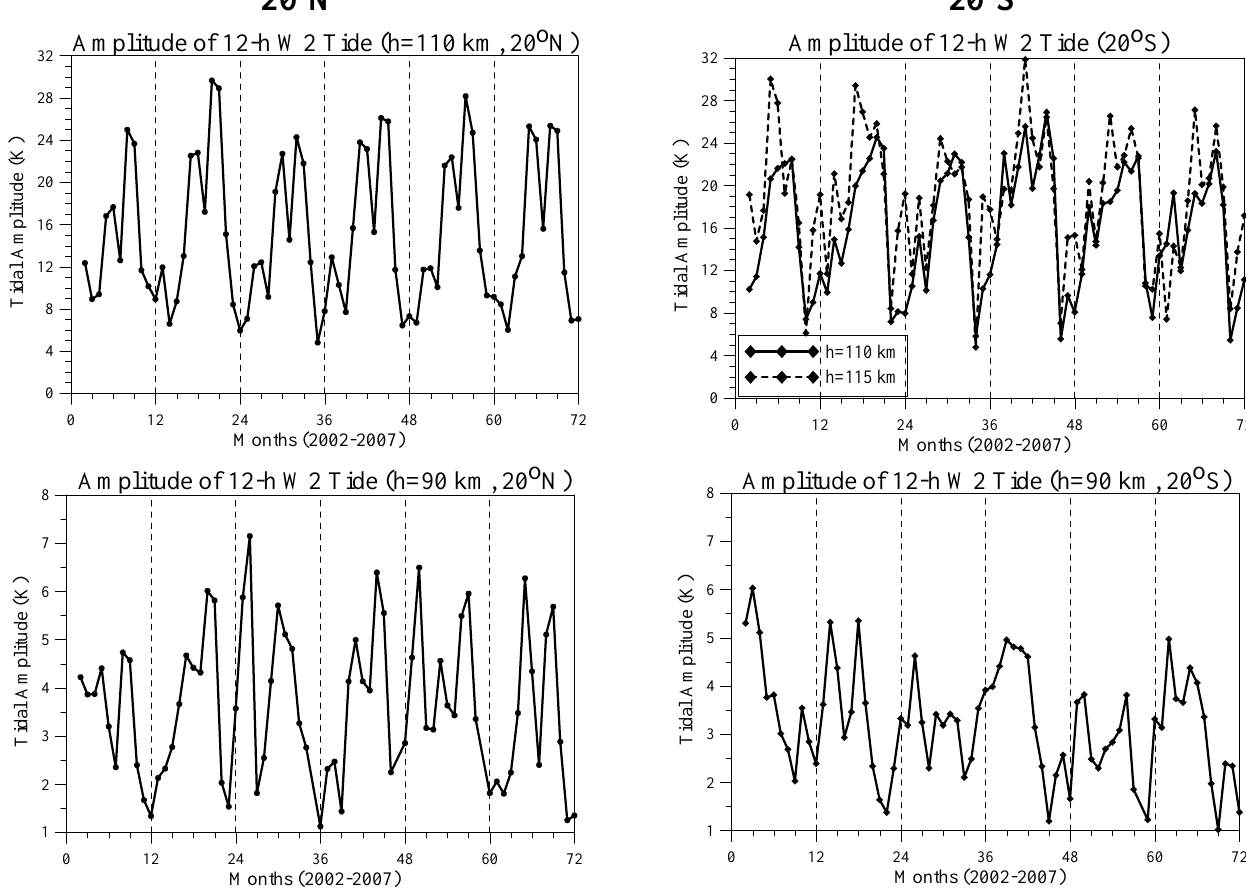
Figure 6 Fig. 6. Temporal distribution of the monthly mean tidal amplitudes at heights: 110km (upper row of plots) and 90km (bottom row) for 20 ◦ N (left column of plots) and 20 ◦ S (right column of plots) shown by solid lines; the monthly mean tidal amplitudes at 115km height at 20 ◦ S are displayed by dash line in the upper right